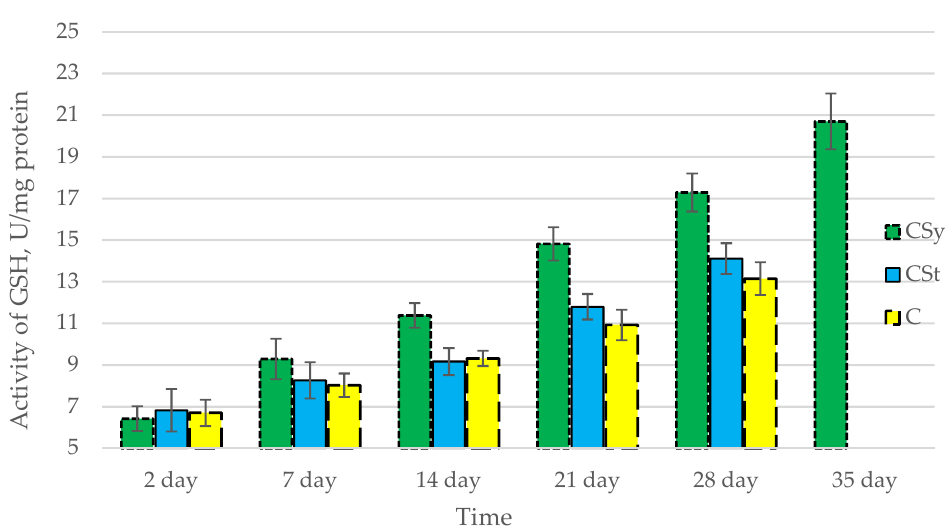
Figure 4. Activities of Glutathione Peroxidase (GPx) in the 2-,7-,14-,21-,28-,35-day-old honey bees’ hemolymph after two methods of supplementation with hemp extract: C–control (pure sugar syrup), Csy–hemp extract in syrup, Cst–hemp extract on strips. (Two-Way ANOVA: supplementa- tion method: F (2,146) = 145,31, p = 0.0000; days of supplementation: F (4,138) = 1093,6, p = 0.0000; supple-